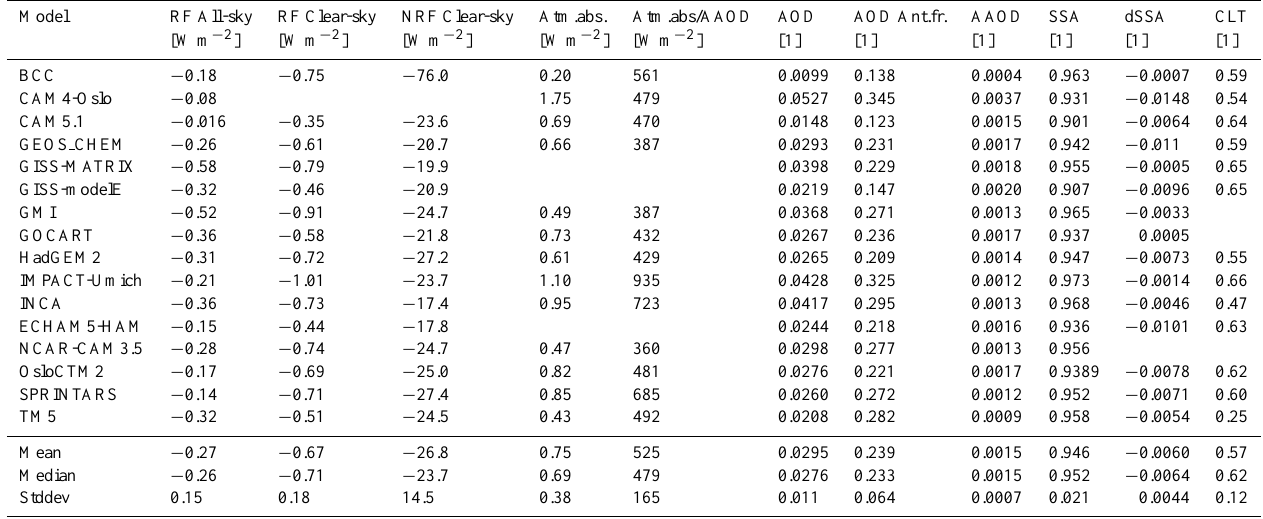
Table 3. Global mean anthropogenic value for all-sky and clear sky RF, normalized RF (NRF) with respect to AOD for clear sky, at- mospheric absorption, atmospheric absorption divided by AAOD, AOD, anthropogenic fraction of AOD, AAOD, single scattering albedo (SSA), combined natural and anthropogenic change in SSA from PRE simulation to CTRL simulation, and present day cloud fraction (CLT). For NCAR-CAM3 the sum of component forcings is used.